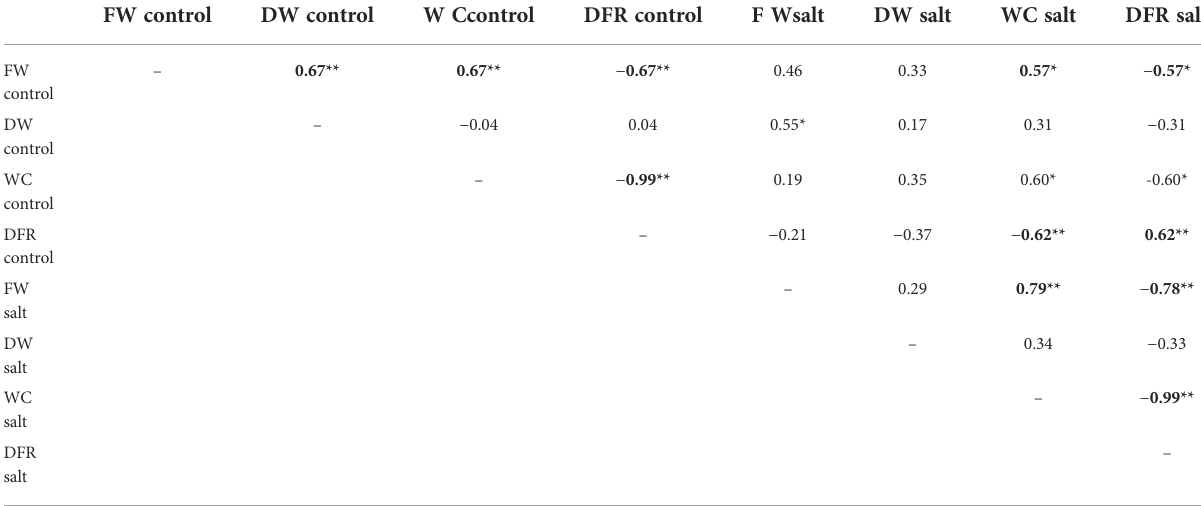
TABLE 3 Pearson ’ s correlation coef fi cients between pairs of